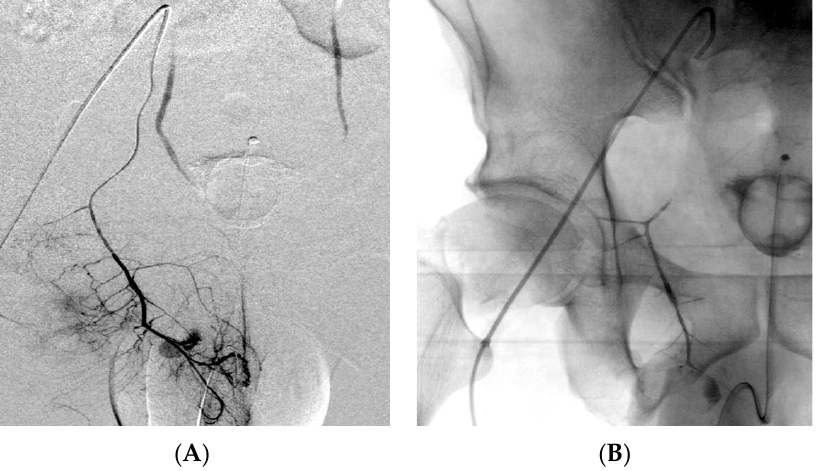
Figure 7. Pedestrian versus motorcycle accident. Selective digital subtraction angiography showing injury of the internal pudendal artery ( A ). The plain radiograph demonstrates the distribution of 1 mL of EVOH copolymer with intrinsically radiopaque tantalum powder (an injection that was performed too quickly resulted in reflux within the parent artery and side branches with no clinical consequences) ( B ).